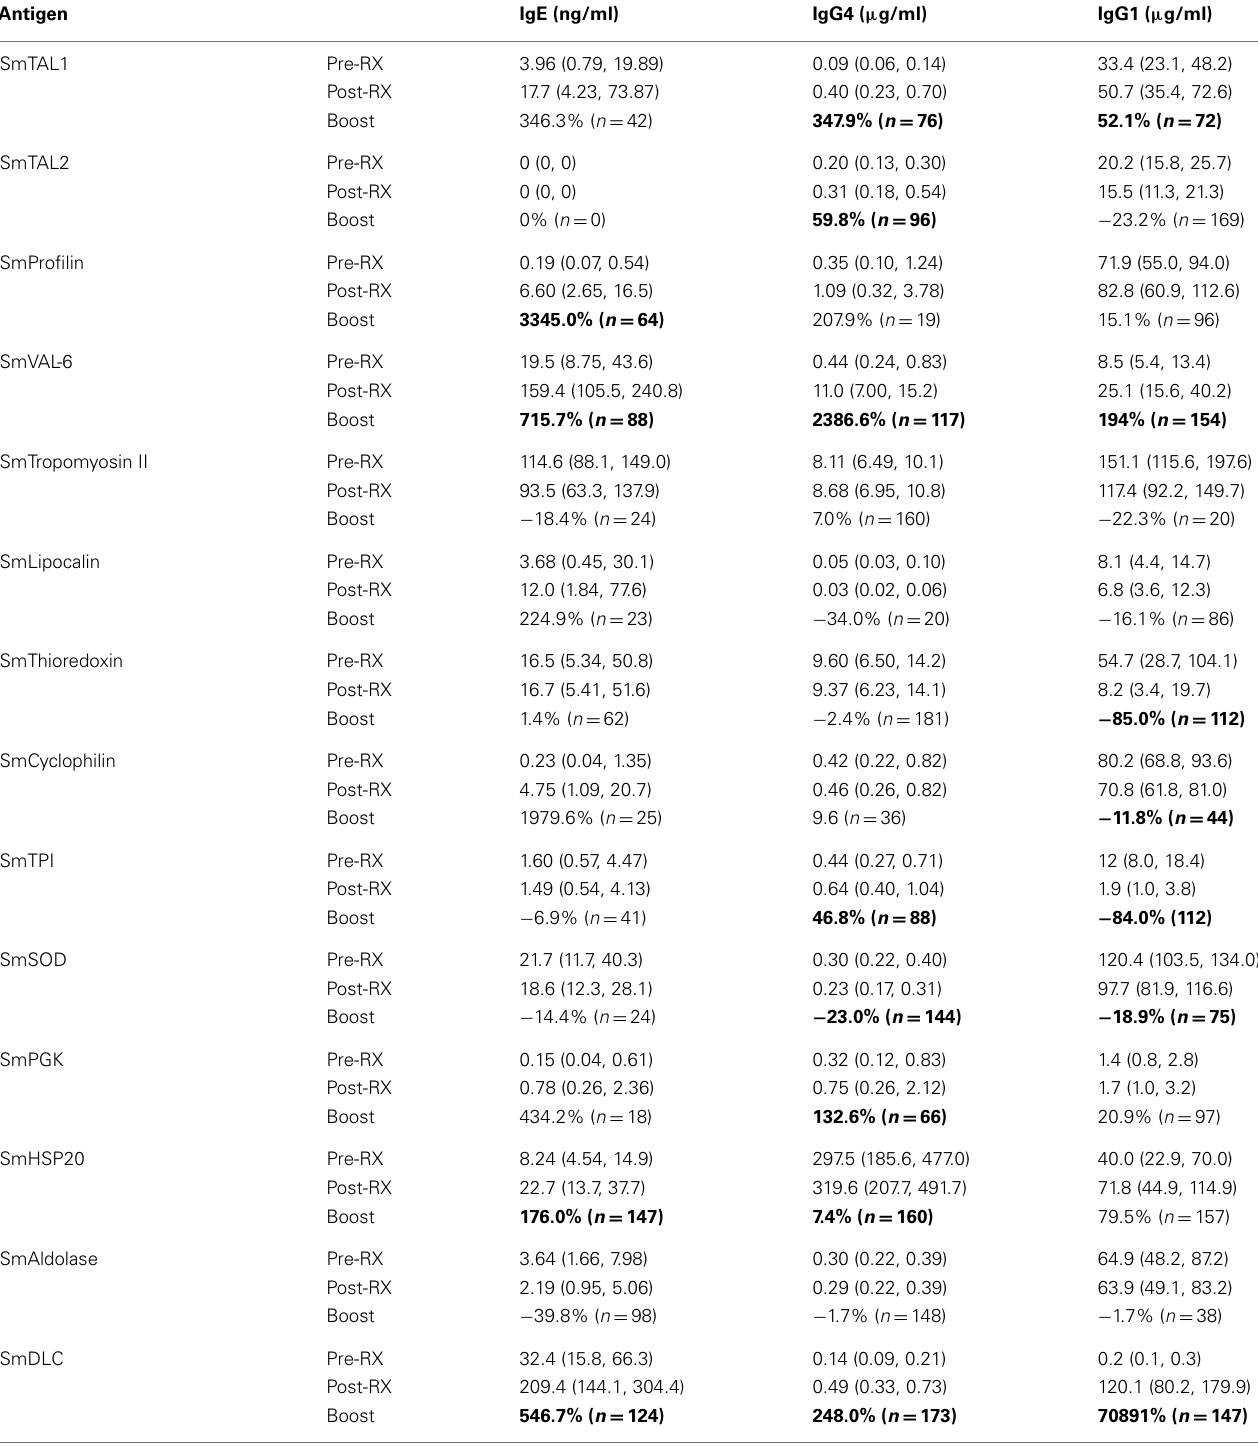
Table 3 | Magnitudes of antibody responses against recombinant S. mansoni antigens in a population of 222 infected individuals as geometric means (Ab magnitude + 0.01) of IgG1, IgG4, and IgE for sub populations of individuals with responses to S. mansoni antigens either pre- or post-treatment with PZQ